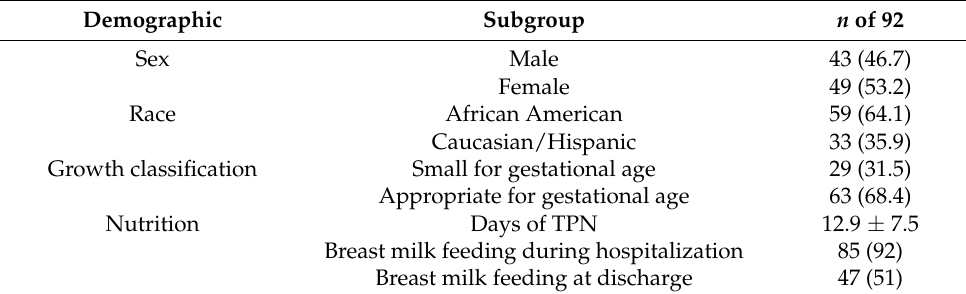
Table 1. Demographics of VLBW AGA and SGA infants ( n = 92).